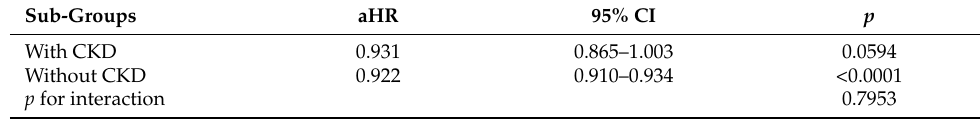
Table 5. Sub-group analysis, aHRs of dementia for use of statin between CKD and without CKD.